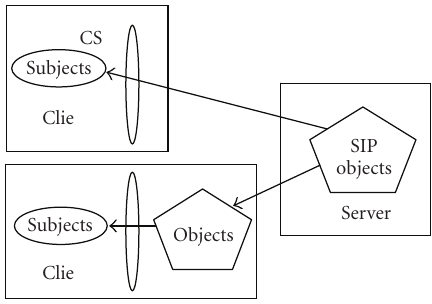
Figure 4: Client-side reference monitor.